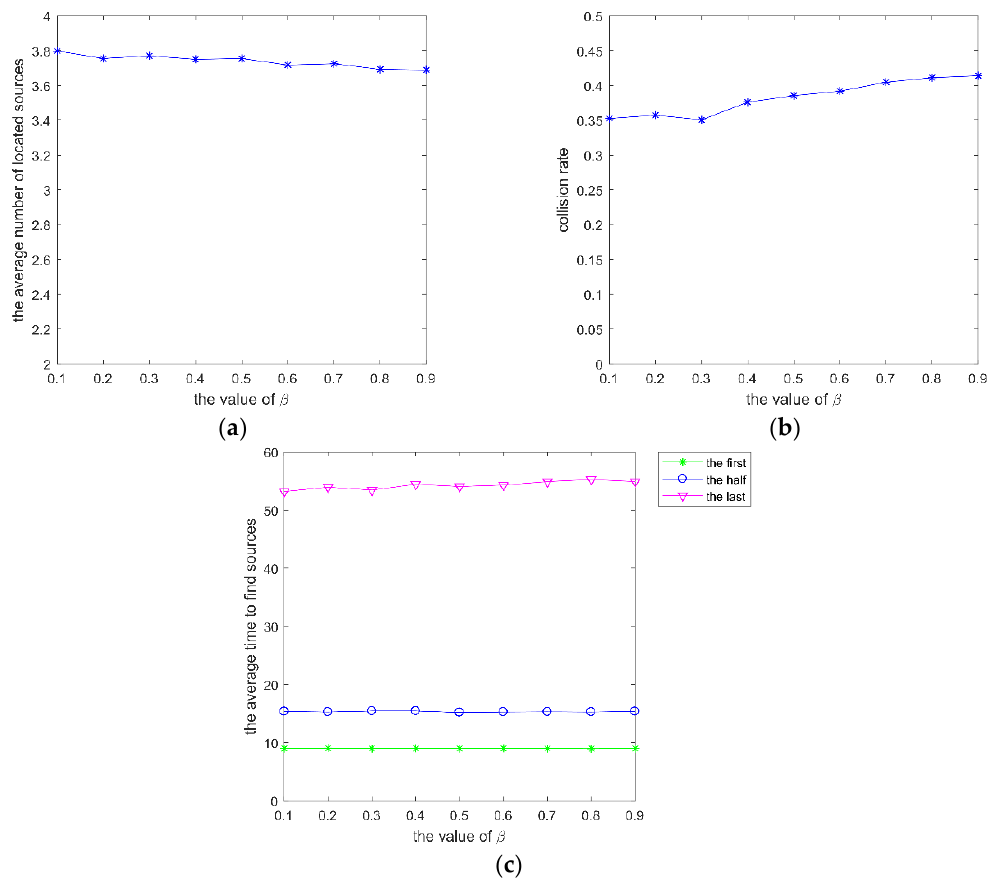
Figure 4. mI of SRPB at di ff erent β , which varies within (0.1, 0.9). ( a ) the average number of located sources; ( b ) collision rate; ( c ) average time to find di ff erent